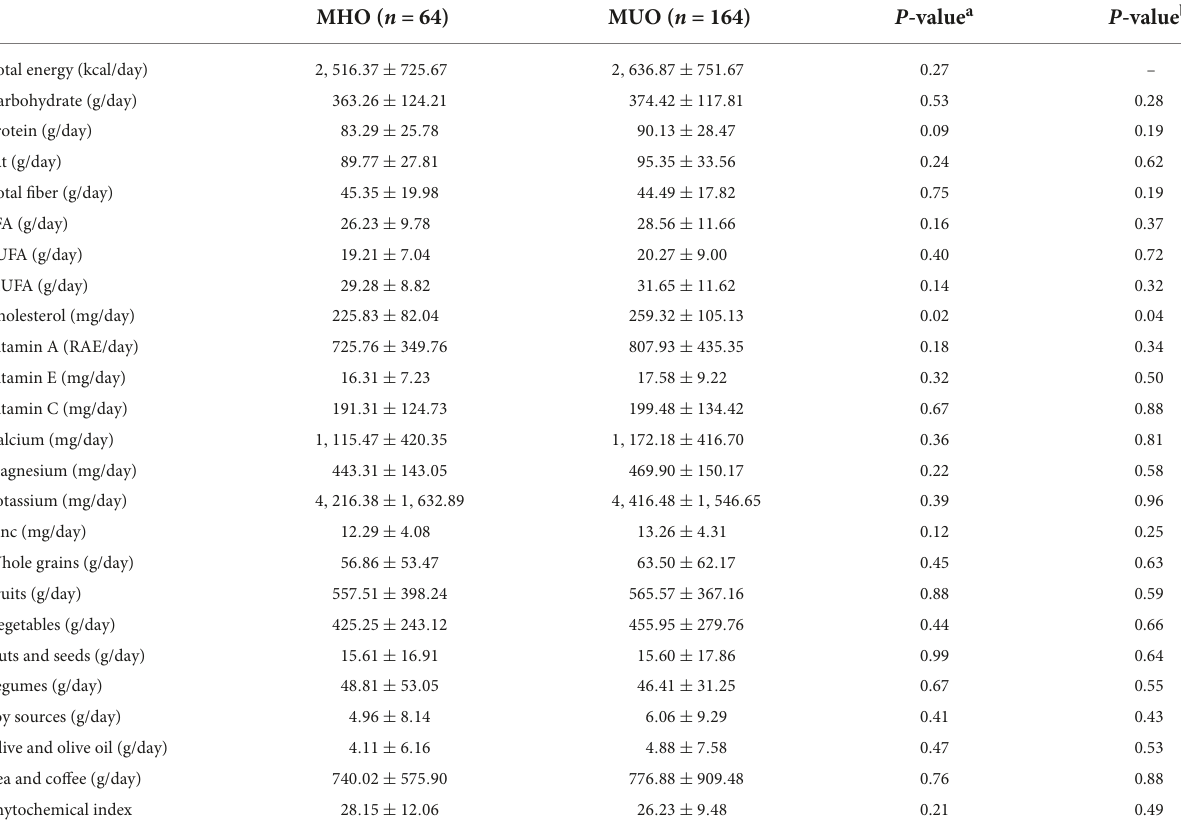
TABLE 2 Dietary intake of MHO and MUO